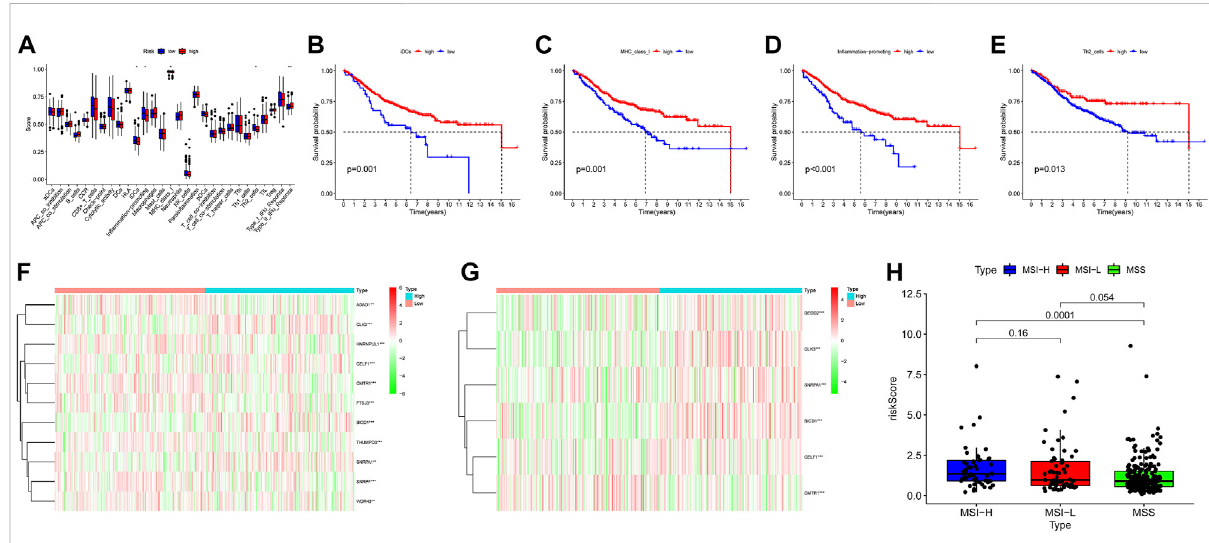
FIGURE 9 Degree of differentiation of the model. (A) Boxplots were used to display the expressions difference of Immune function score quanti fi ed by ssGSEA. p p < 0.05; pp p < 0.01; ppp p < 0.001. (B – E) Survival analysis of two group divided by the median of Immune function score. (F,G) Heatmap display the expressions difference of gene mRNA in the 13 gene signature. (H) Rank-sum test was used to identify risk scores differences in microsatellite